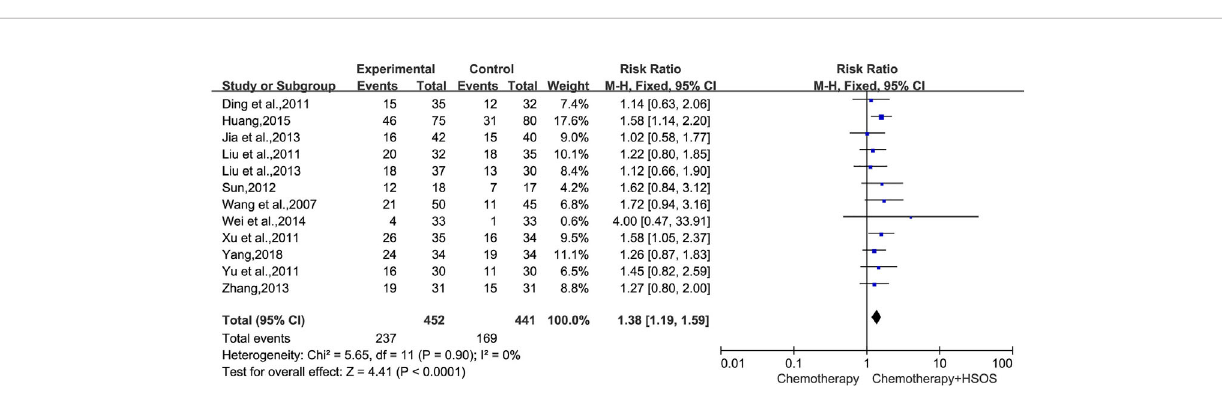
FIGURE 3 | Forest plot of improved ORR with chemotherapy combined with HSOS versus chemotherapy